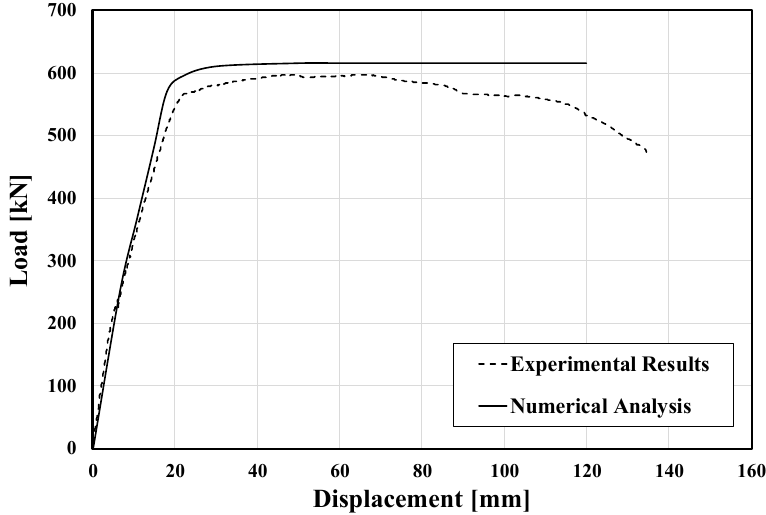
Figure 18. Comparison between the numerical and the experimental results of load versus mid- Figure 18. span deflection.